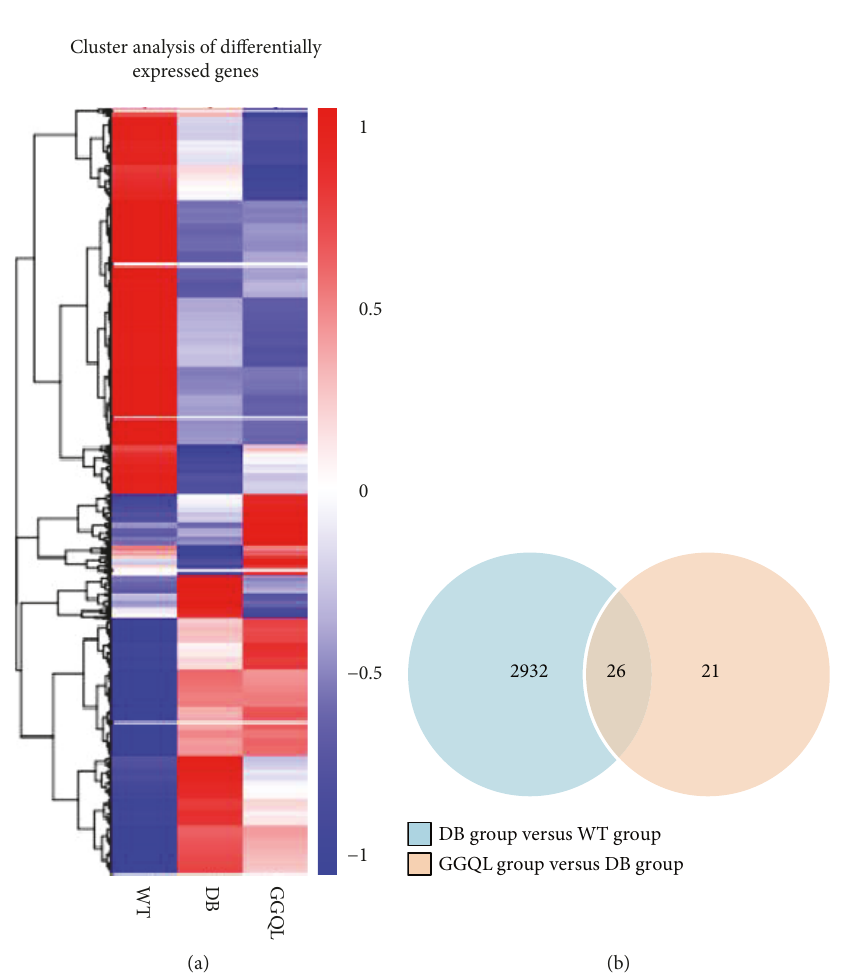
Figure 3: (a) Heatmap for cluster analysis of di ff erentially expressed genes. (b) Venn diagram of di ff erentially expressed